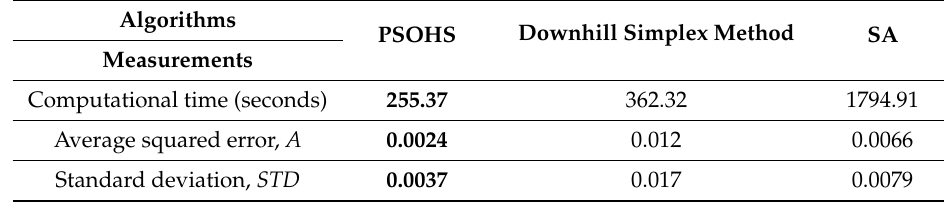
Table 4. Comparison between the performance of PSOHS, the downhill simplex method, and SA in estimating sixteen parameters for threonine in terms of computational time, average squared error, and standard deviation.